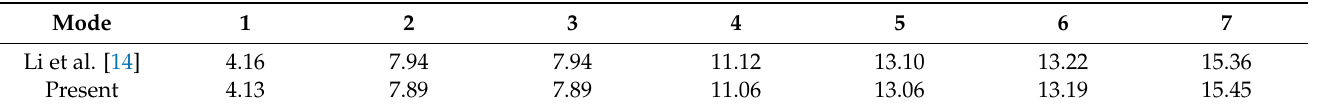
Table 3. Natural frequency parameters for clamped FGM square plates under a thermal environment of 300 K.